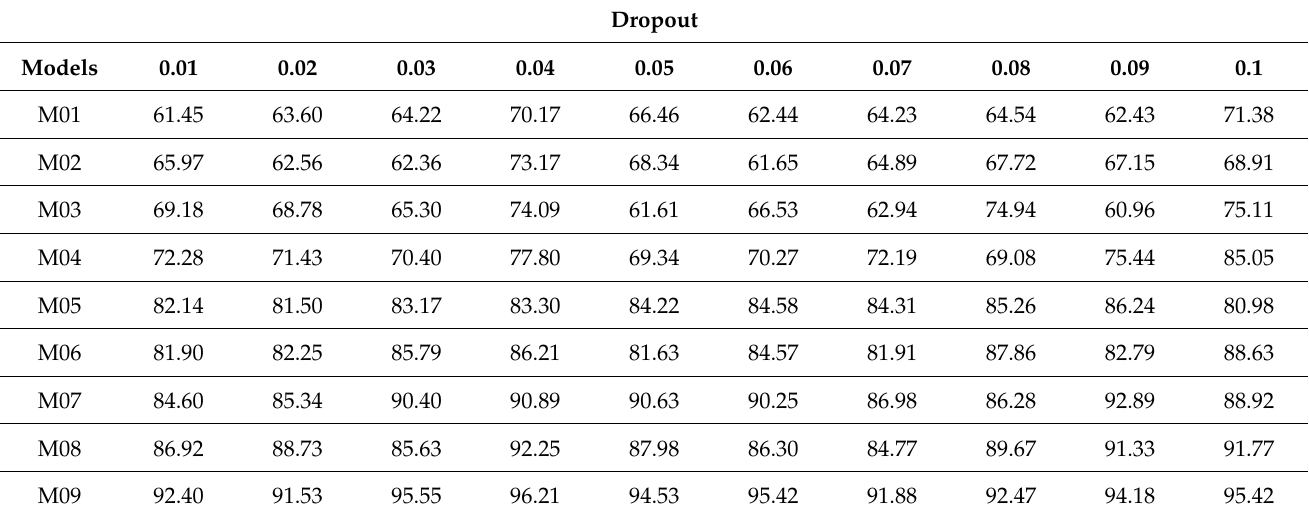
Table 8. Average classification accuracy (%) results for an embedding size of